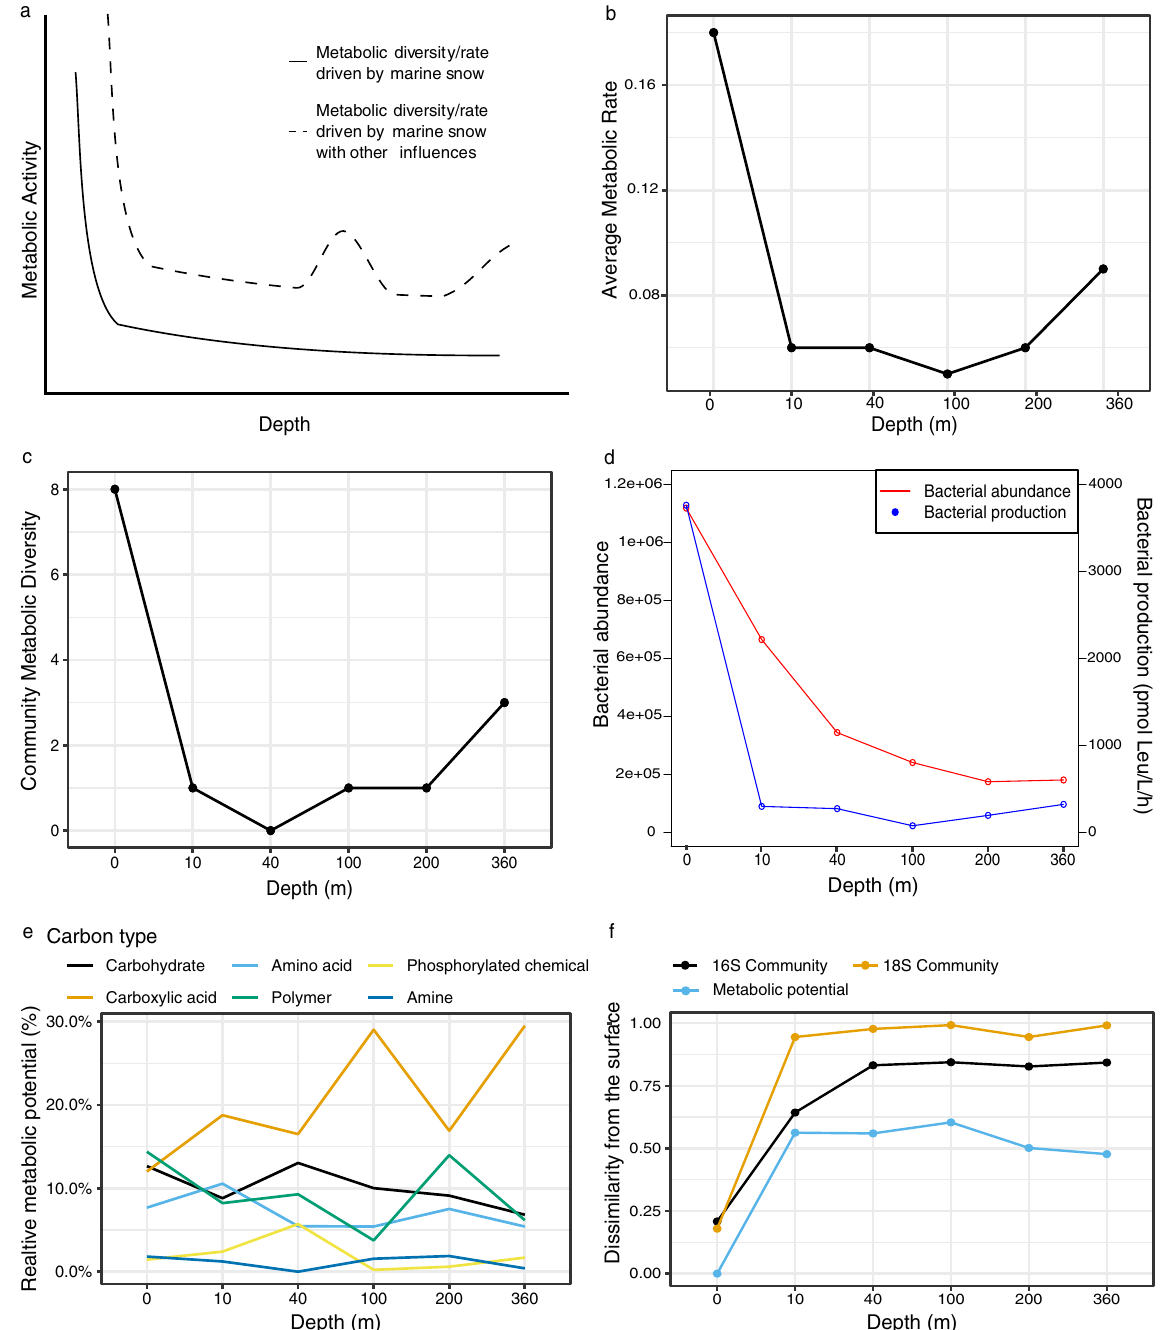
Figure 2. Benthic and surface influence on metabolic potential. Two potential metabolic scenarios are depicted ( a ), the metabolic rate and diversity when driven solely by photosynthetic production, and another model that accounts for additional benthic influences. Biolog Ecoplate plate derived Average Metabolic Rate (AMR, b ), Community Metabolic Diversity ( c ), and the relative metabolic potential ( e ) are also shown in addition to the bacterial abundance and productivity ( d ), and taxonomic and Biolog plate derived dissimilarity (Bray–Curtis) from the surface ( f ). Different colours represent carbon source groups ( e ; carbohydrates are blue, carboxylic acids are orange, amino acids are light blue, polymers are green, phosphorylated chemicals are yellow, and amines are dark blue), and Bray–Curtis dissimilarity data sources ( f ; the 16S community is black, 18S community is orange, and Biolog derived metabolic potential is light